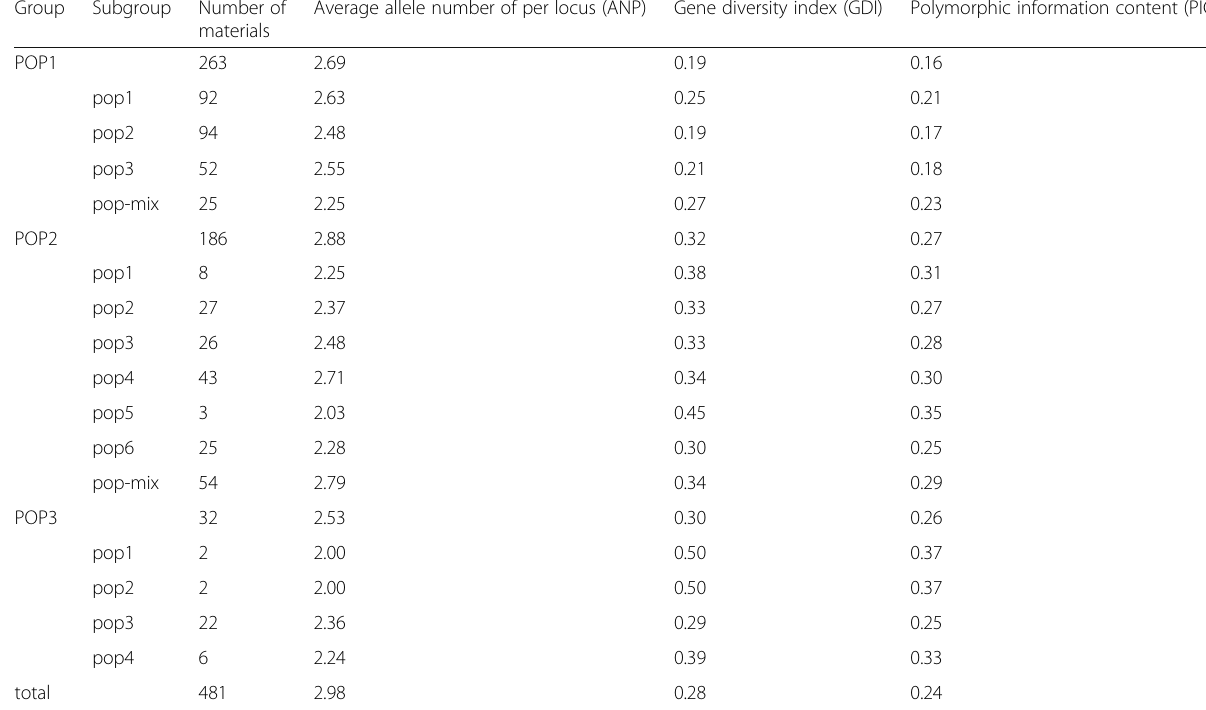
Table 5 Statistical results of the genetic diversity of the groups Group